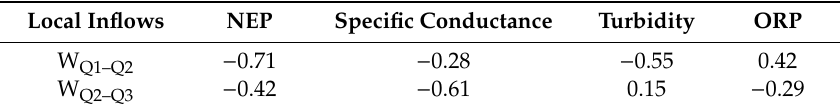
Table 12. Spearman correlations between local inflows (W Q1–Q2 and W Q2–Q3 ) along the Kanawha River and their corresponding changes on the net ecosystem production (NEP), specific conductance, turbidity and